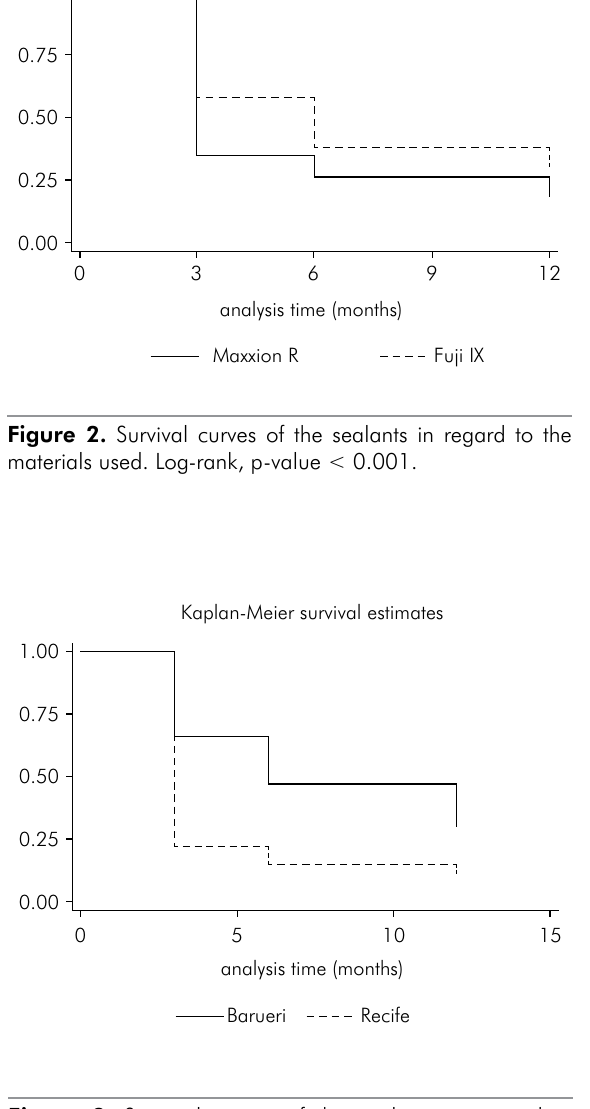
Figure 3. Survival curves of the sealants in regard to the city where the treatments were performed. Log-rank, p-value < 0.001.